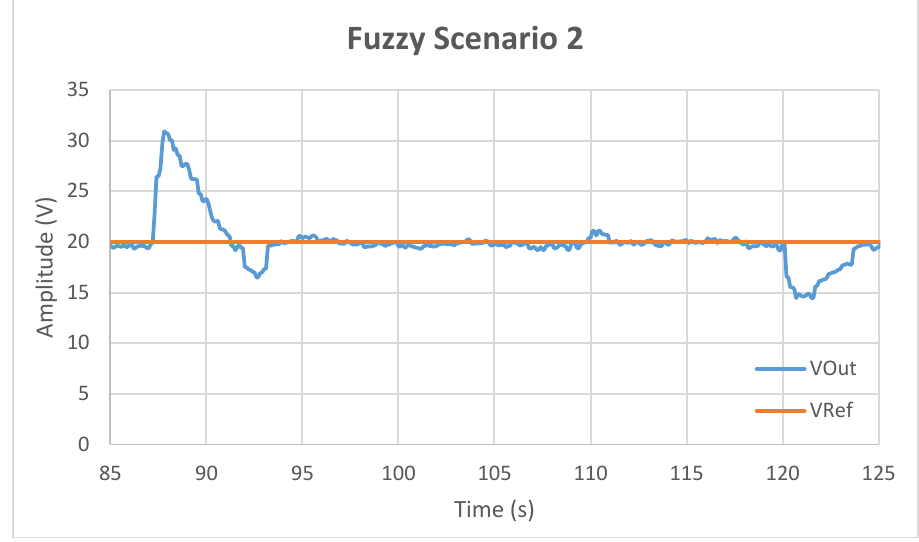
Figure 18. The results of set point changes with fuzzy logic controller on 85 to 125 s.